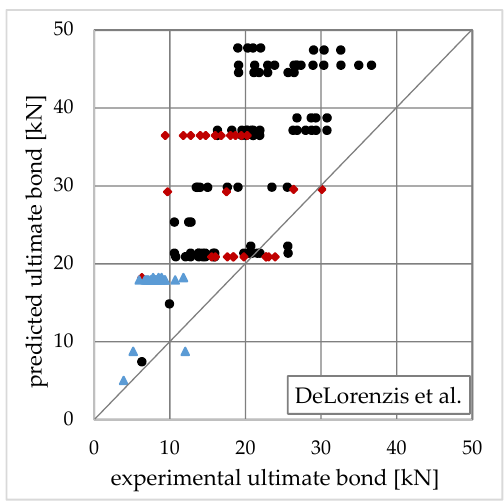
Figure 16. Test vs. predicted bond force using the Chen and Teng model [28].